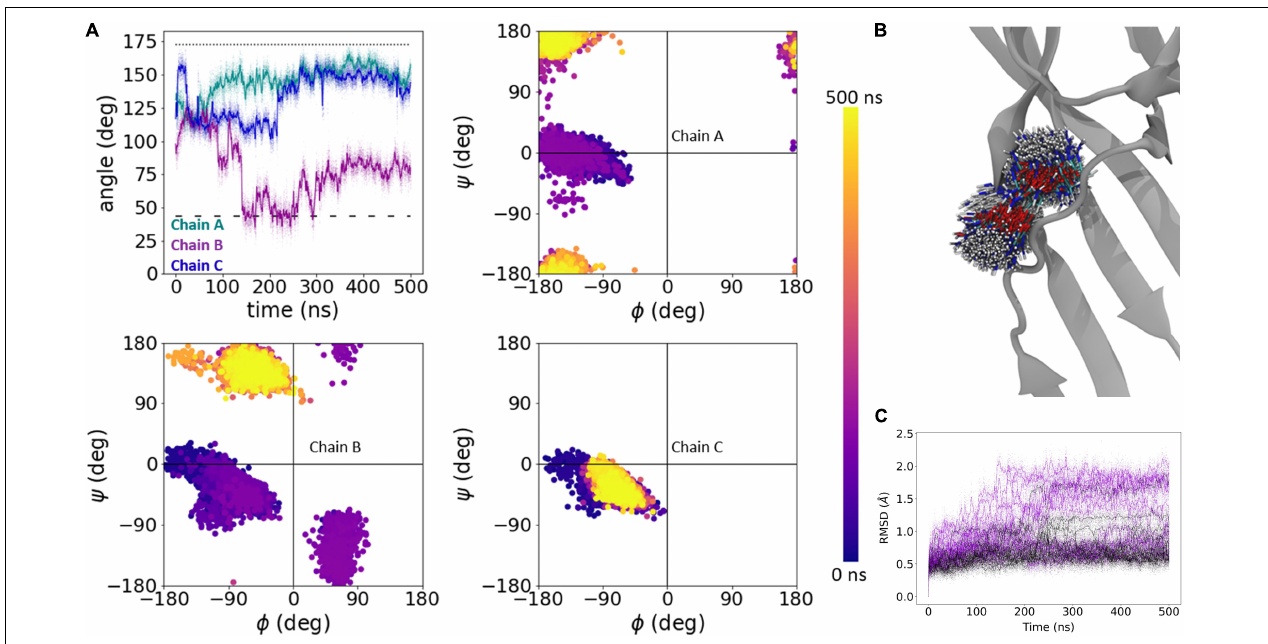
FIGURE 5 | Dynamics of Asn415 in L414D mutation. (A) Side chain angle (upper left) and phi/psi plots (upper right, lower) of Asn415 chains in L414D simulation, run 2. The dotted line illustrates the side chain angle of N415 in the desensitized state structure while the dashed line illustrates the side chain angle in the resting state structure. (B) 1000 snapshots from chain B, at regular intervals, from simulation in panel (A) . (C) Calculated RMSD of individual chains as a function of time for C α atoms of amino acid residues 409–420 of wildtype (black) and L414D mutant (violet). Raw data is plotted in the background as transparent dots, smoothed data is plotted as a solid